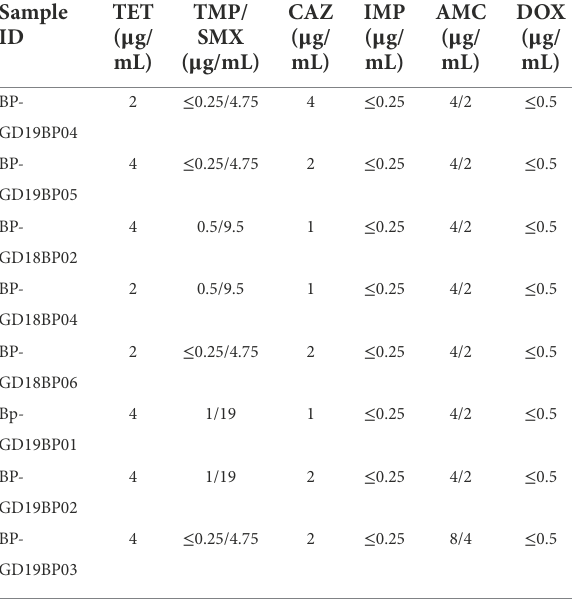
TABLE 2 Minimum inhibitory concentrations (MICs) of the eight clinical B. pseudomallei